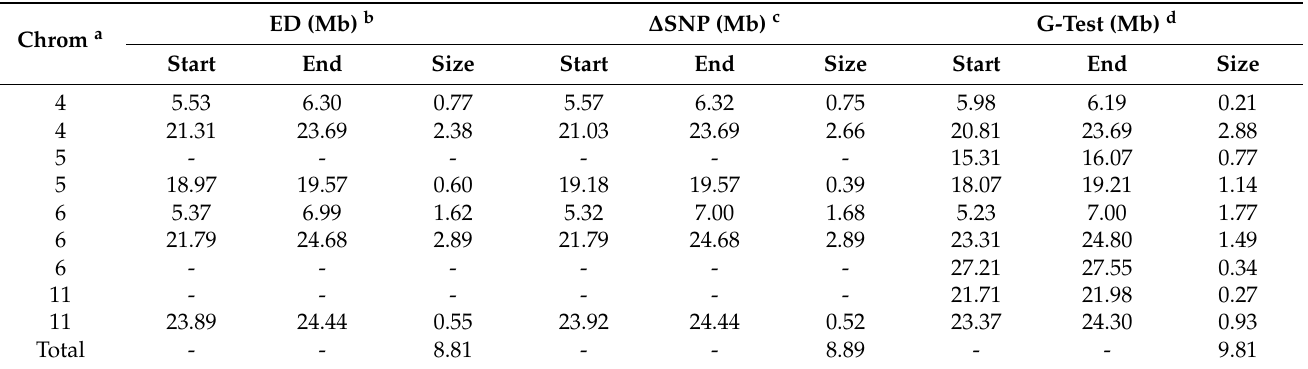
Table 4. QTLs detected for cold tolerance in a rice RIL population using different statistics in